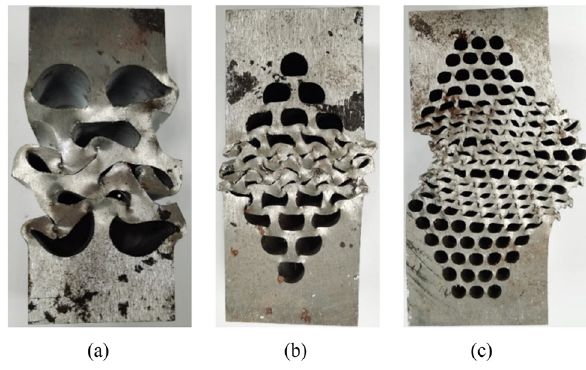
Figure 5: Three typical failure modes: ( a ) Type I, ( b ) Type II, and ( c ) Type III.